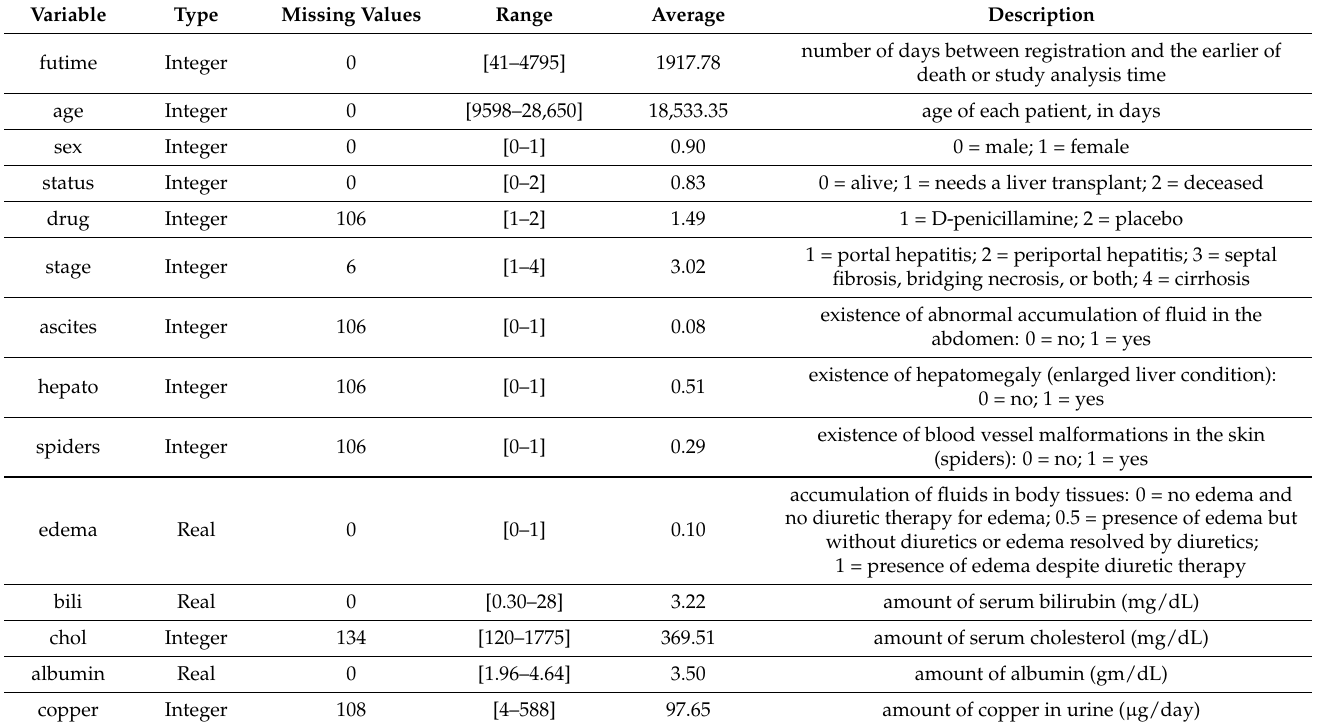
Table 1. Description of the attributes in the given data before the modifications made in the Data Preparation